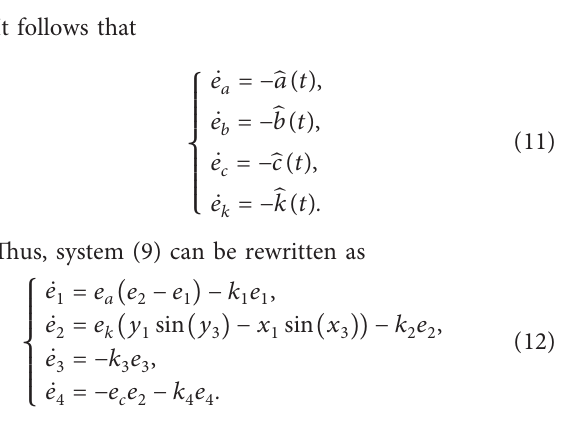
Figure 18: Experimental phase portraits from the microcontroller-based implementation of system (2): (a, b) projections on x x − x planes for chaotic attractor; (c, d) projections on x 2 4 − x and x planes for periodic attractor. 2 4